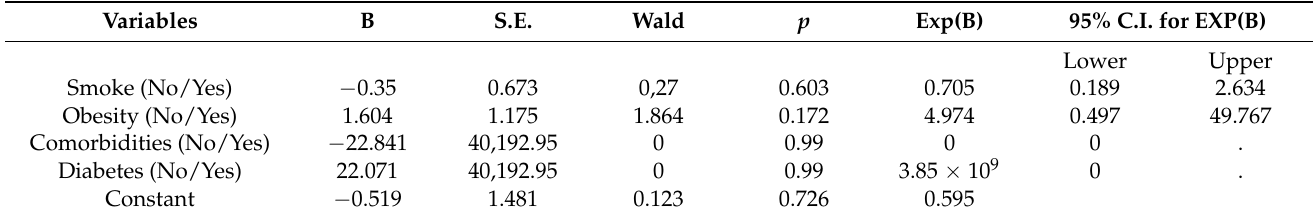
Table 7. Logistic regression